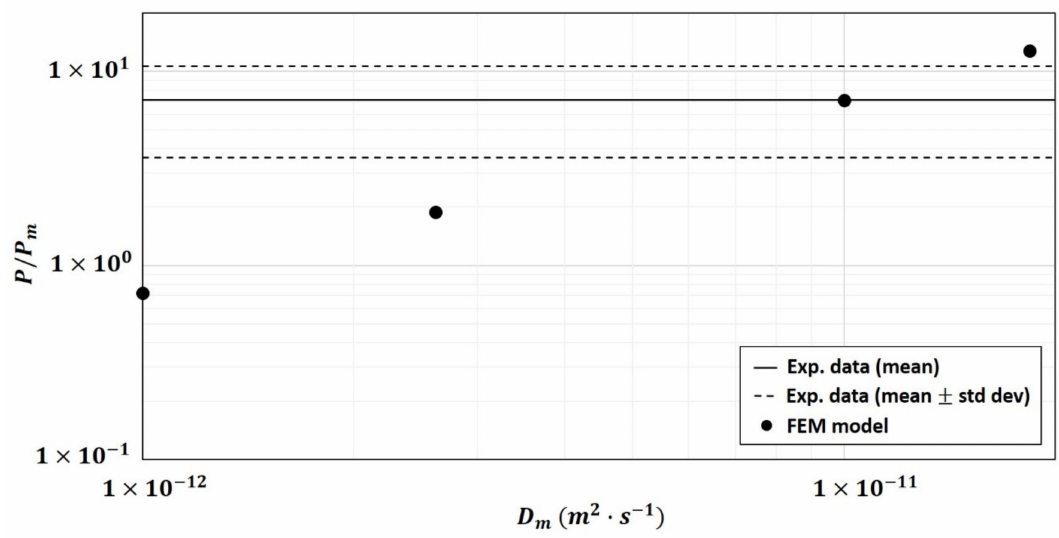
Figure 9. Effect of matrix diffusivity D m on numerical relative permeability P / P m (calculated using the 2-phase model) into the composite of ϕ p = 19.52 % v / v (hypothesis tested on 10